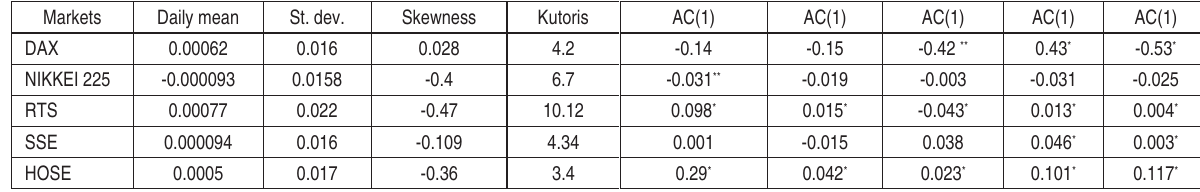
Table 2. Statistics summary for daily returns